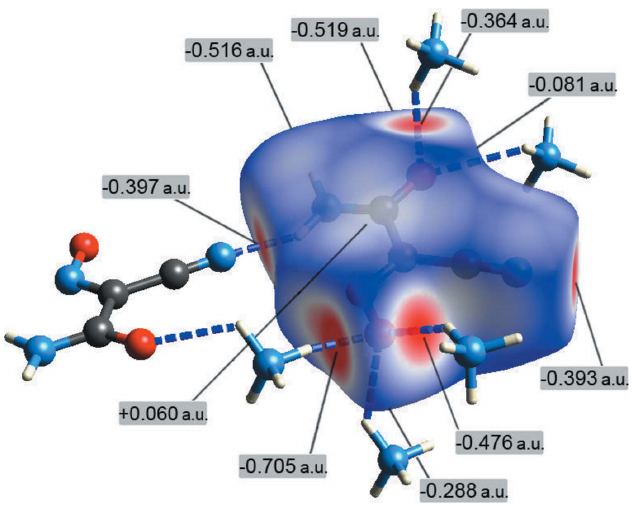
Figure 6 The Hirshfeld surface of the (nccm) (cid:3) anion mapped over d norm in the color range (cid:3) 0.71 (red) to 1.05 a.u. (blue), in the environment of the hydrogen-bonded ammonium cations and one (out of three) (nccm) (cid:3)